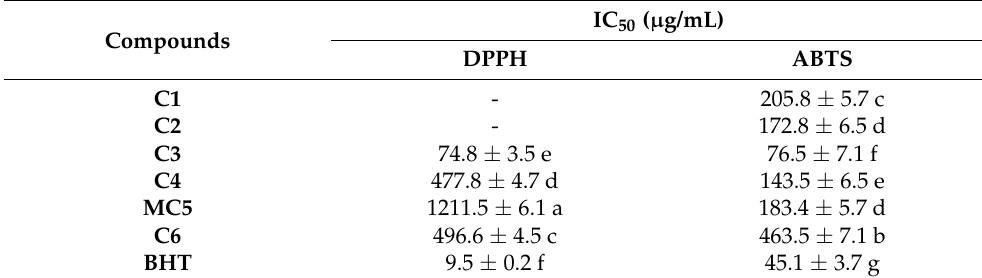
Table 4. Antioxidant activity of compounds isolated from kava